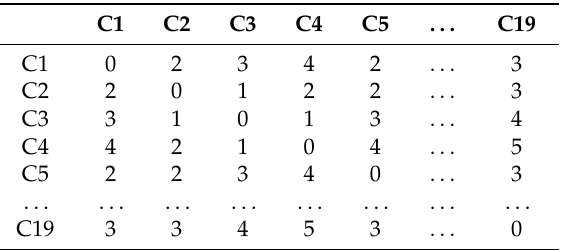
Figure 6. Indoor cellular space. C9 is the stairwell, C13 is the elevator, and C18 is the hallway. The top view is floor 1, and the bottom view is floor 2. Table 4. The adjacency distance